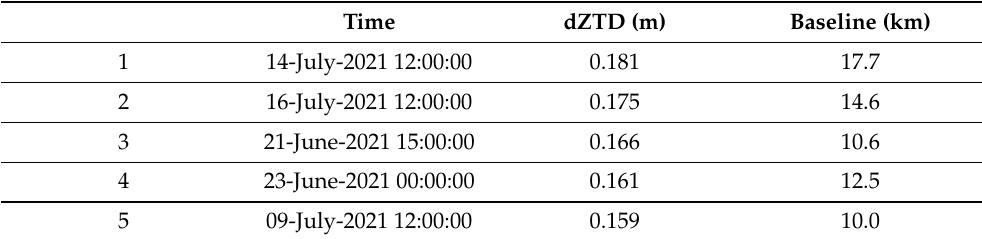
Table 2. List of dZTD